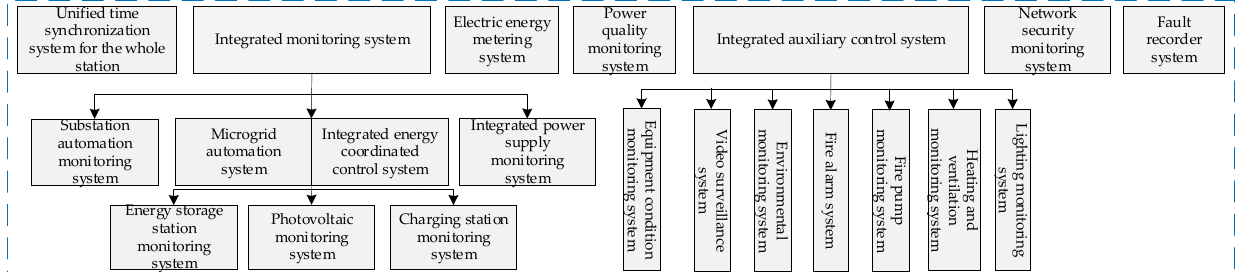
Figure 2. Information service systems of SESt.